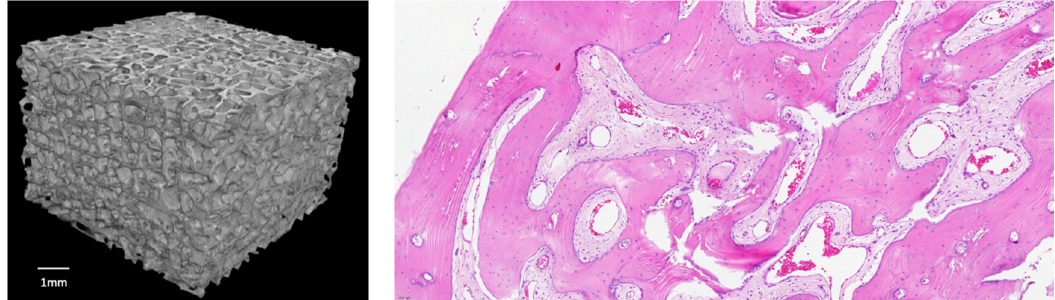
Figure 1. ( left ) 3D reconstruction from a CT scan (Bruker system) on an exemplificative SB block 7 × 7 × 7mm (reference bar is 1mm); ( right ) H/E staining on a histologic sample taken after 2.5 years post SB implantation: the graft is completely substituted, and the osteogenesis has formed a lamellar bone with cement lines; a lot of osteocytes inside the lacunae and a good angiogenesis are evidenced (adapted from Grecchi et al. [21]).